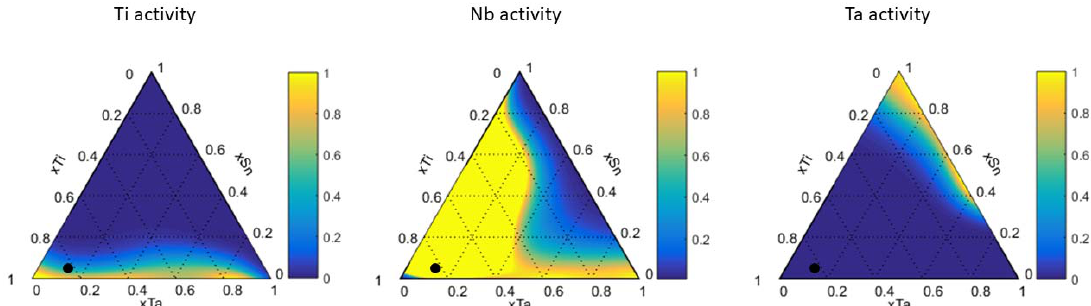
Figure 2. ( a ) Ternary diagram of Gibbs free energy of mixing and ( b ) ideal Gibbs free energy of mixing, for the Ti ‐ Ta ‐ Sn system at 298 K.